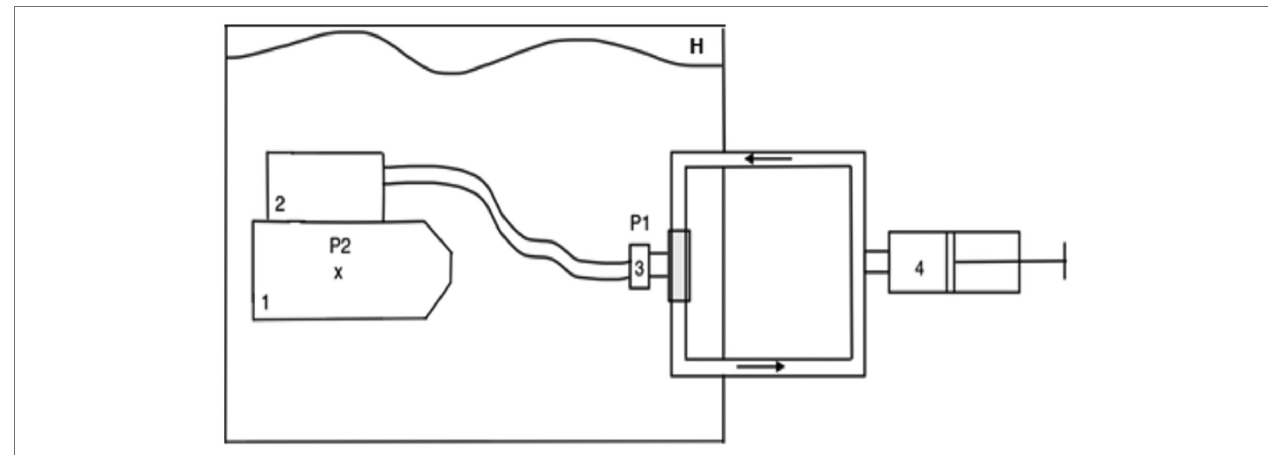
FIGURE 1 | Principle of the measurements on the ventilator simulator. The mannequin and rebreather are immersed in water of a sufficient depth to preclude surface effects, but no deeper than 2 m. 1 = mannequin, x = lung centroid, 2 = rebreather, 3 = rebreather mouthpiece, 4 = pump with valve for unidirectional flow in the circuit, P1 and P2 = pressure sensors (differential pressure sensor), H = hyperbaric